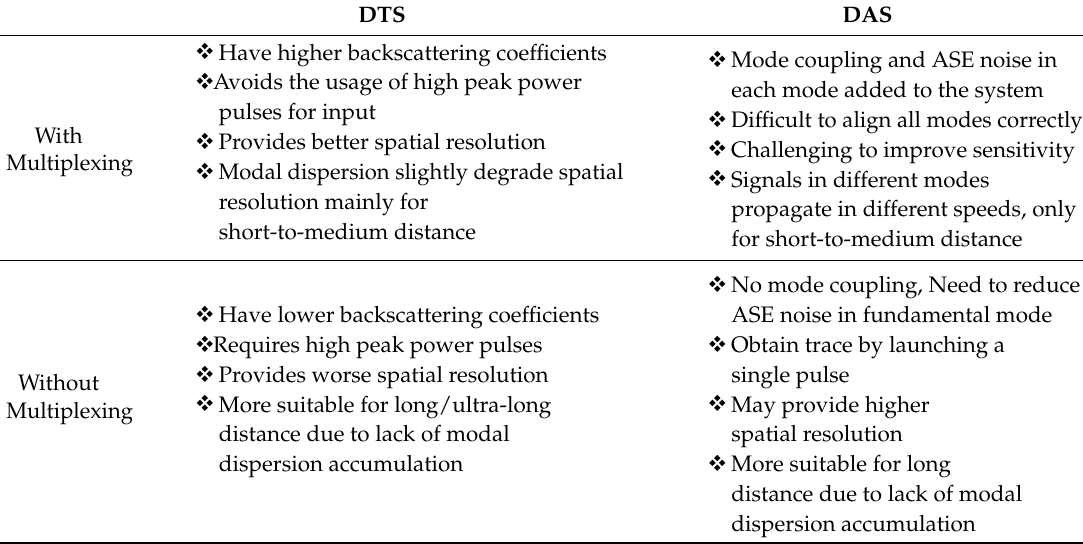
Figure 20. ( Left ) The whispering gallery under a dome of St. Paul’s cathedral and ( Right ) the sound intensity profile showing the whispering gallery mode (WGM) [148].